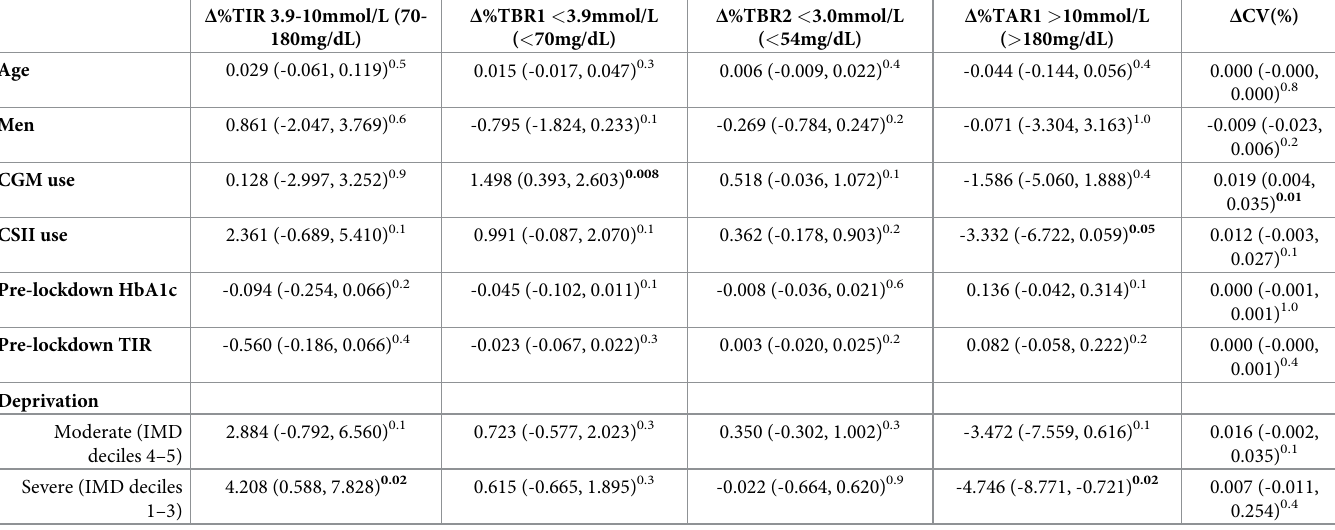
Table 3. Multiple linear regression analysis of predictors of change ( Δ ) in %times in range and CV for blood glucose from pre-lockdown to lockdown for the com- bined adult and paediatric cohorts (n =